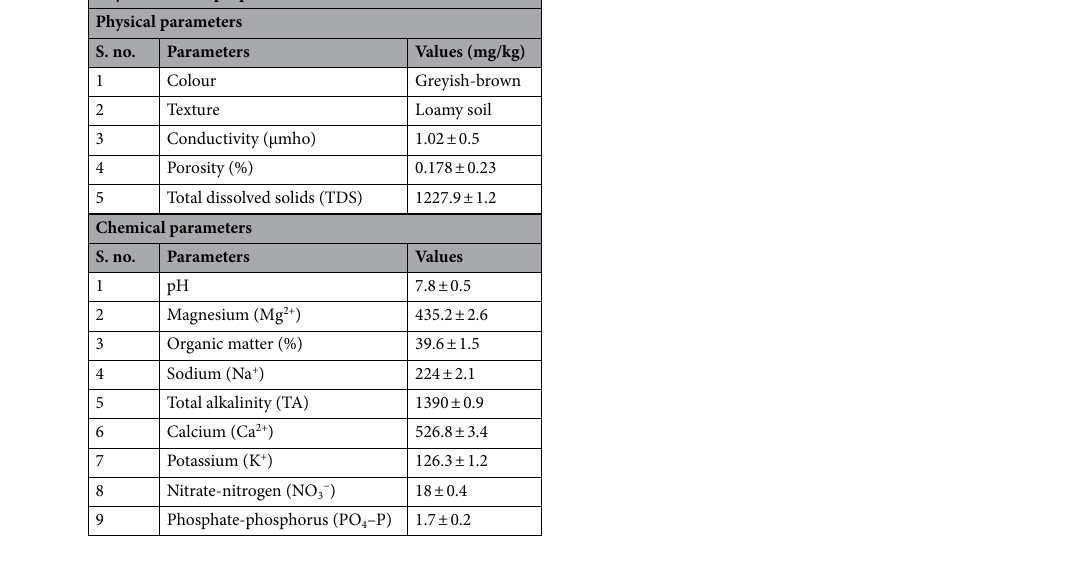
Table 1. Physiochemical properties of